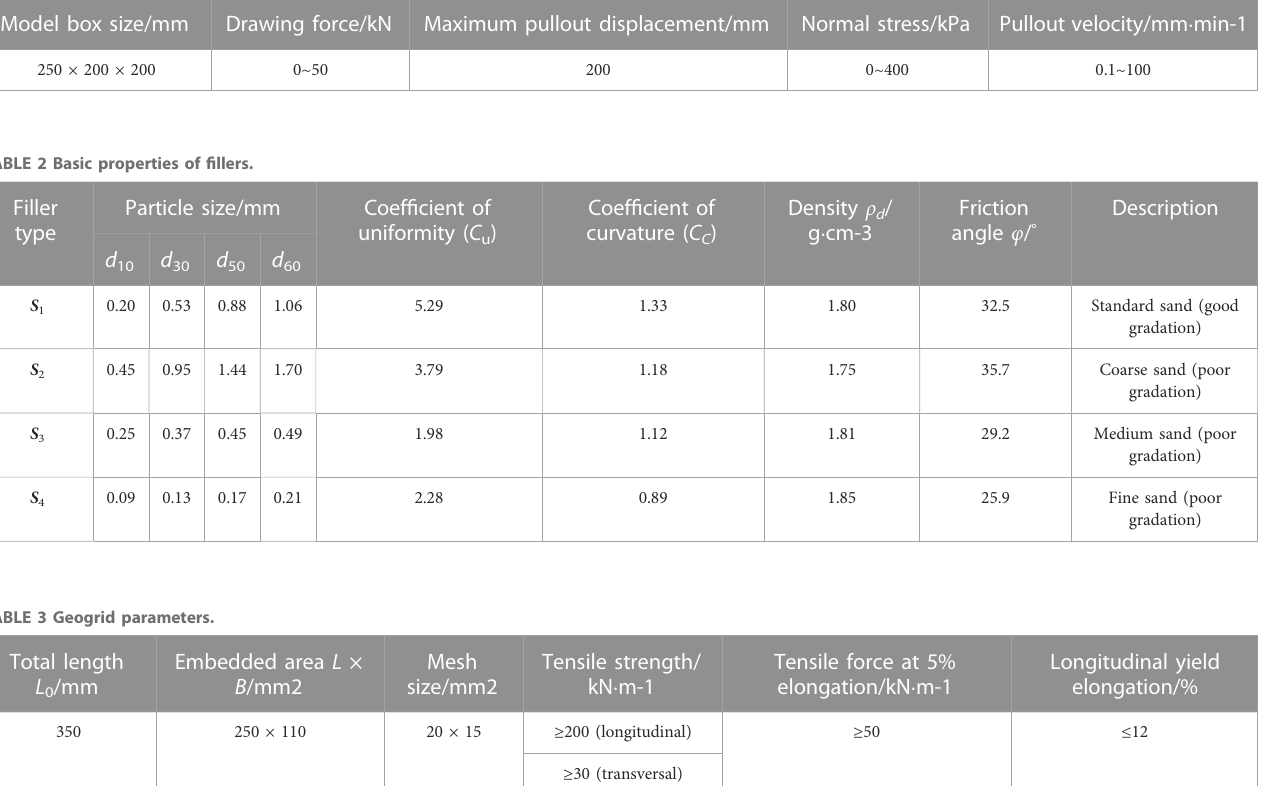
TABLE 1 Main indexes of the test device.